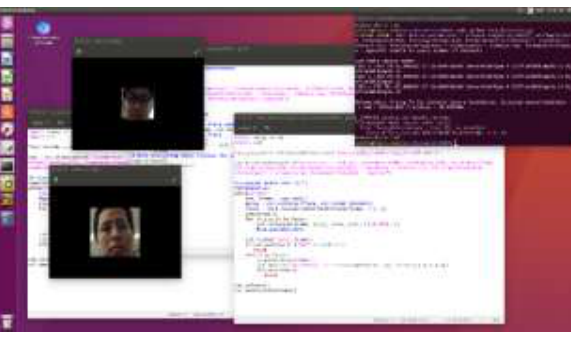
Fig. 6. face detection using